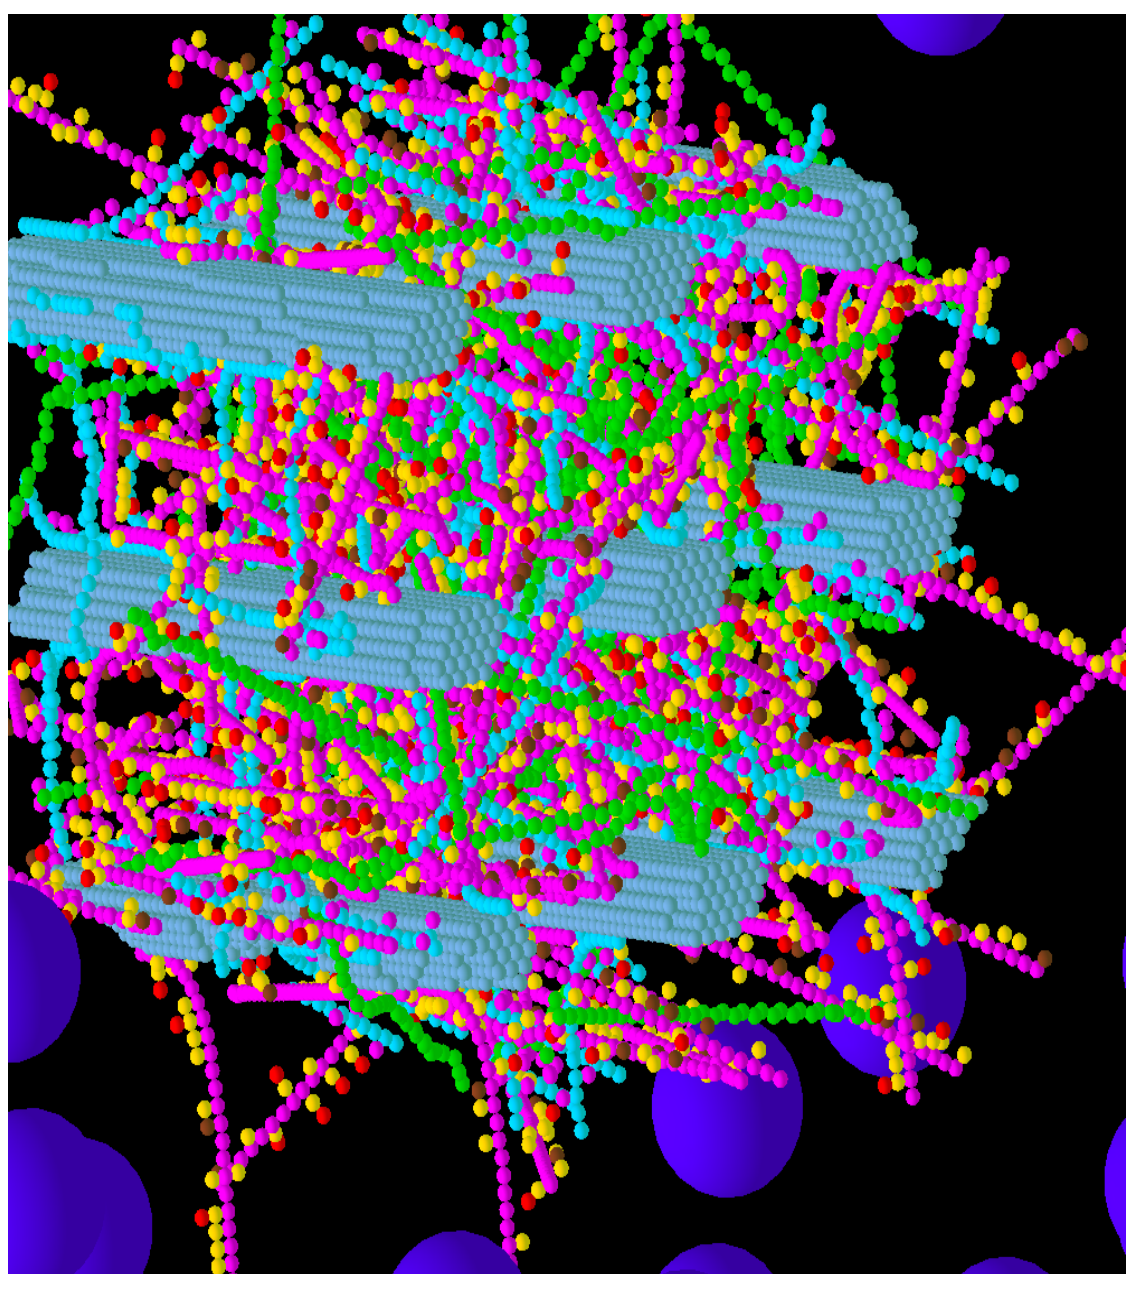
Figure 5. The degraded perennial ryegrass mesophyll cell wall (MCW) after the simulated enzyme action showing degradation of hemicelluloses and cellulose at the periphery of the wall after a simulation run involving Cel51A enzymes alone. Glucose, xylose, arabinose, glucuronic acid, ferulic acid and galacturonic acid are represented by the smaller spheres coloured blue, magenta, yellow, brown, red and green respectively. Larger purple spheres represent Cel51A